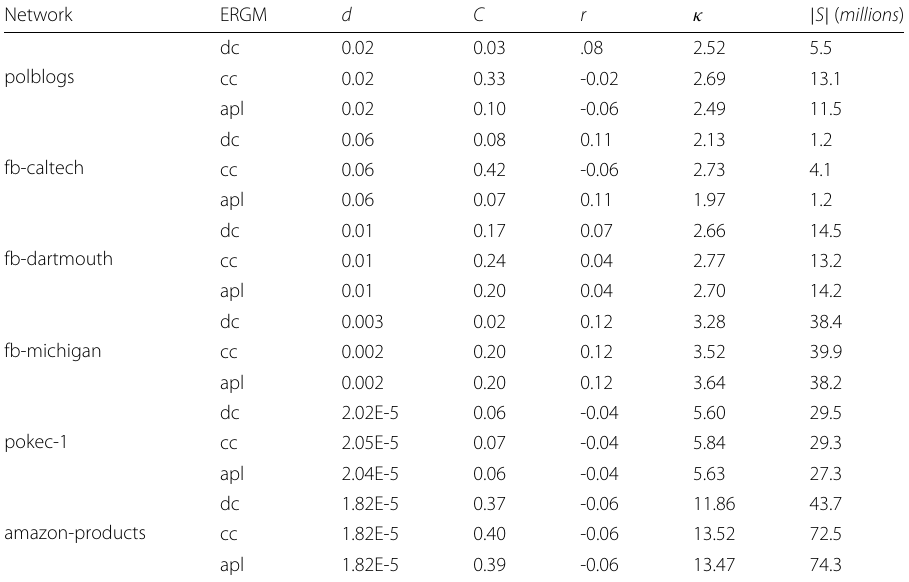
Table 2 Basic statistics of generated ERGM networks, and the population of node pairs Network ERGM d C dc polblogs